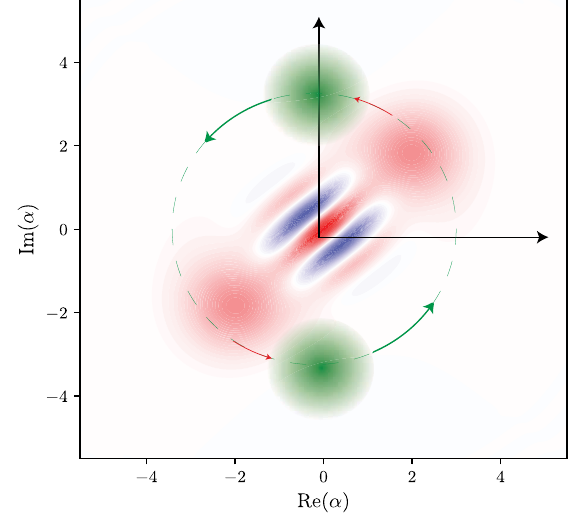
FIG. 4. Wigner function of the state of a cat qubit during the execution of an X operation. The green dots are the Wigner functions of the instantaneous steady states of the dynamics _ ρ ¼ κ D ½ ˆ a 2 − α ð t Þ 2 (cid:3) . These attractive points are slowly rotated 2 from (cid:4) α to ∓ α on the dashed circle, as shown by the green arrows. When this rotation is performed slowly, the cat follows the attractors (red